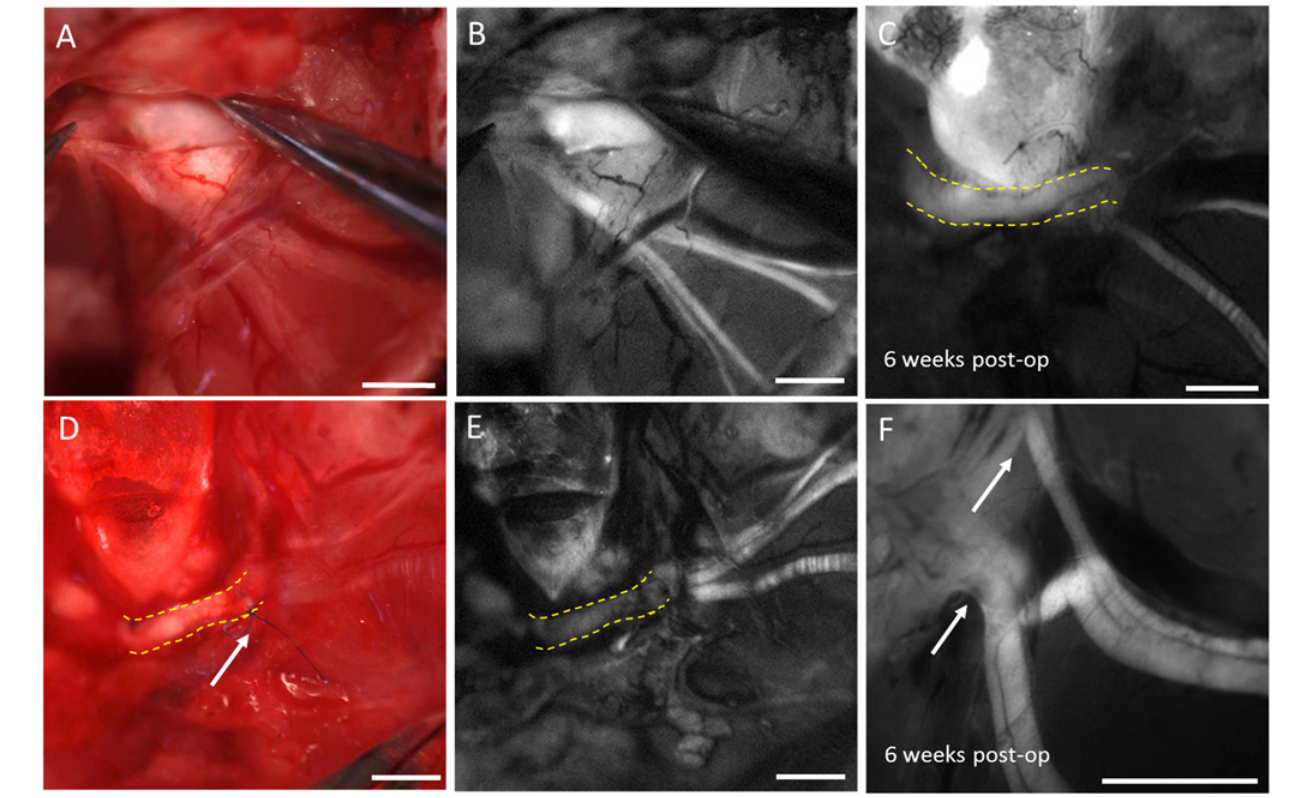
Fig 4. Intraoperative nerve visualization with fluorescence during repair surgery and to show postoperative nerve graft integration. Repair surgeries with a sciatic nerve graft were performed six weeks after nerve transection. Intraoperative fluorescence guidance improved visualization of the degenerated distal nerve stump (white light image A versus corresponding fluorescence image B ). After nerve graft implantation (yellow stippled outline in corresponding WL and fluorescence images D and E ) with epineural sutures (white arrow in d), the donor graft did not show any fluorescence signal. 6 weeks after the repair procedure, the graft (yellow stippled outline in c ) showed fluorescence signal after systemic F-NP41 injection indicating graft acceptance and established blood supply. F shows a high magnification fluorescence image of the regenerating distal nerve branches sprouting into the nerve graft (white arrows). Scale bars in a, b, d, e: 1mm, in c, f: 0.3mm.